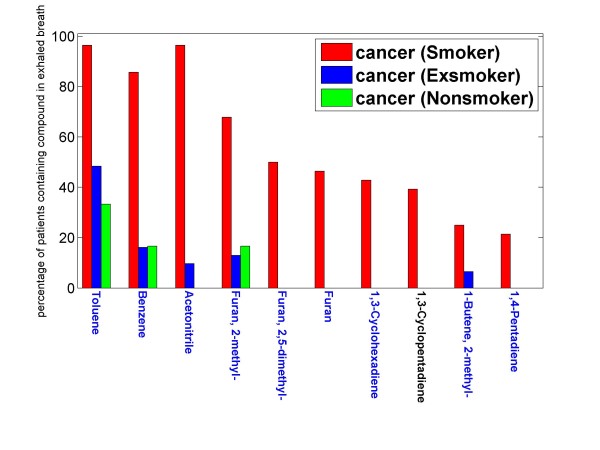
Compounds observed in exhaled breath of cancer patients which are related to smoking behavior (GCMS). Only those measurements have been considered, which show at least 15% higher concentration in exhaled air than in indoor air. The relative proportions for observations with respect to smoker patients (red), ex-smoker patients (blue) and non-smoker patients (green) is shown. Nine compounds (blue) were identified by retention time and by spectral library identification. One compound, namely 1,3-cyclopentadiene was not commercially available and therefore only identified by spectral library match. Acetonitrile and toluene arise in almost every smokers' exhaled breath. p-Values computed according to the method of Agresti and Caffo [51] are smaller than 0.0001 with the exception of 2-methyl-1-butene and 1,4-pentadiene, where p < 0.05.